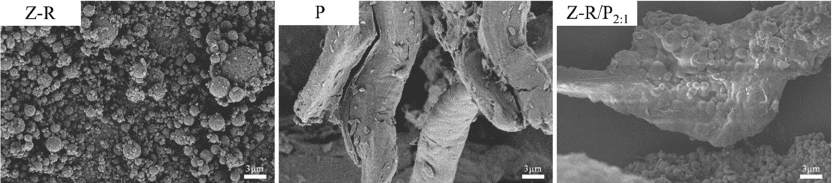
Figure 2. SEM images of zein–resveratrol conjugate (Z-R), zein–resveratrol/pectin (Z-R/P 2:1 ) and pectin (P) particles.